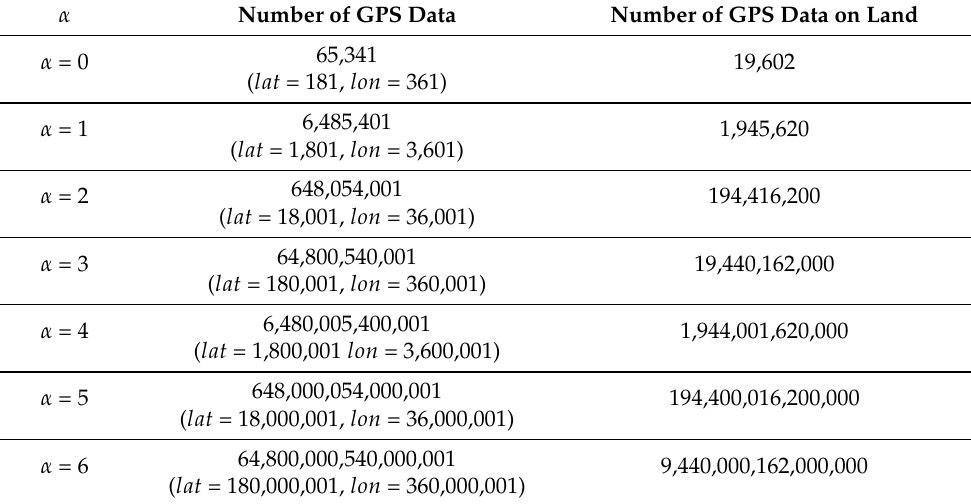
Table 2. Number of GPS data depending on α . α Number of GPS